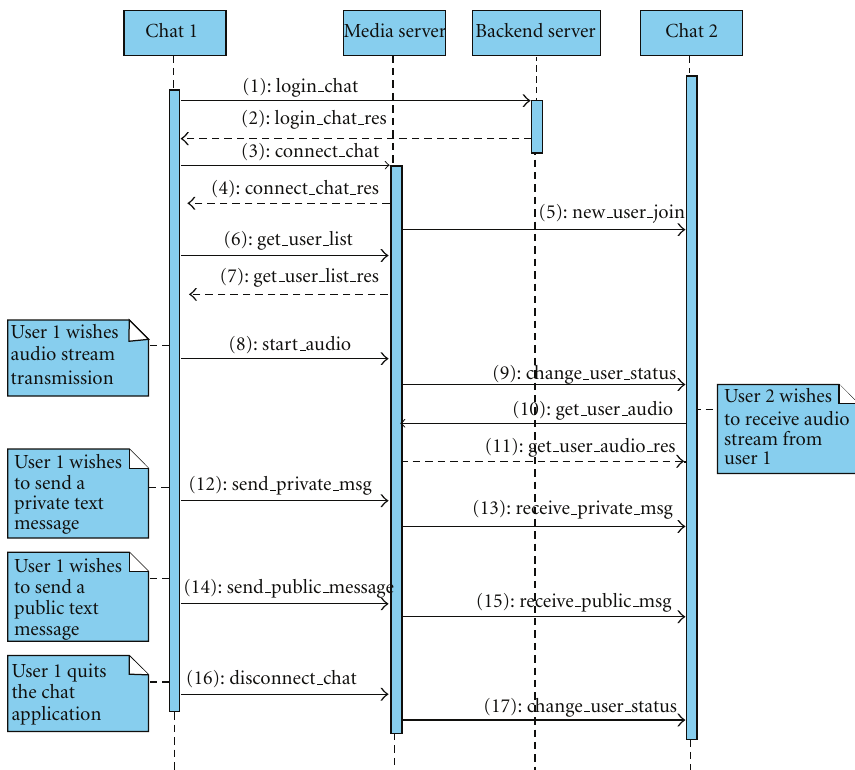
Figure 7: Sequence diagram presenting the operation of the CNG chat application with respect to its interaction with the CNG